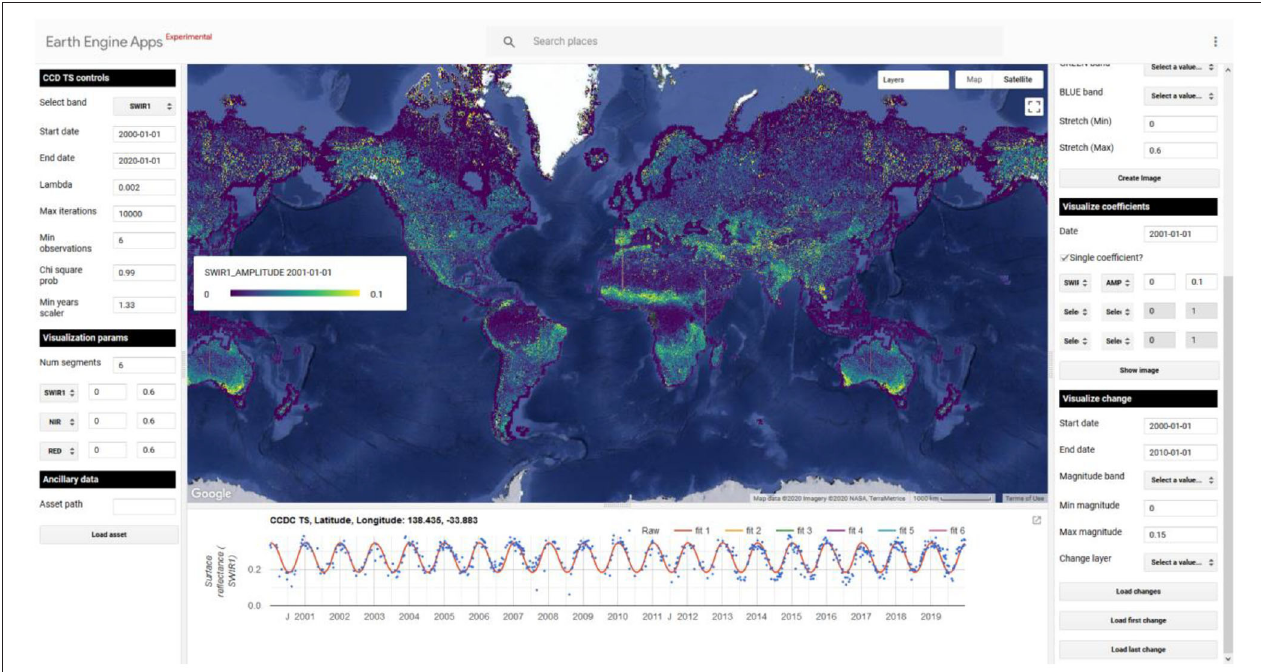
FIGURE 5 | Screenshot of the spatial data viewer interface, showing the amplitude of the temporal models for the SWIR1 band for the first day of 2001. Brighter values (yellow) represent locations with a more pronounced seasonality in the surface reflectance of the first Landsat SWIR band. At the bottom, the time series and fit temporal model for a clicked pixel in southeastern Australia. The right panel is used to load model coefficients, synthetic images or change layers. The left panel is used to change the parameters to run CCDC on-the-fly in a clicked pixel, and to control the visualization of Landsat images loaded by clicking on the time series